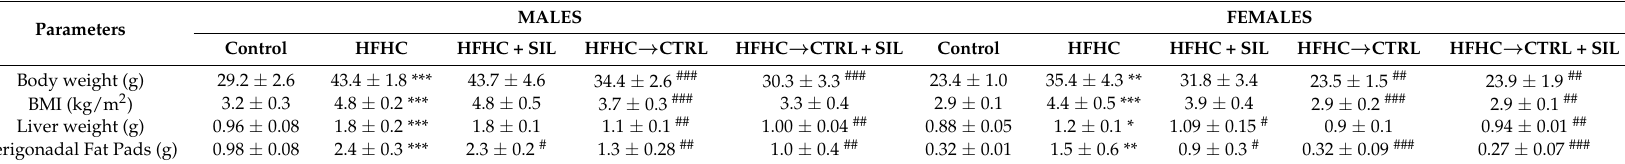
Table 2. Macroscopic features in males and females.